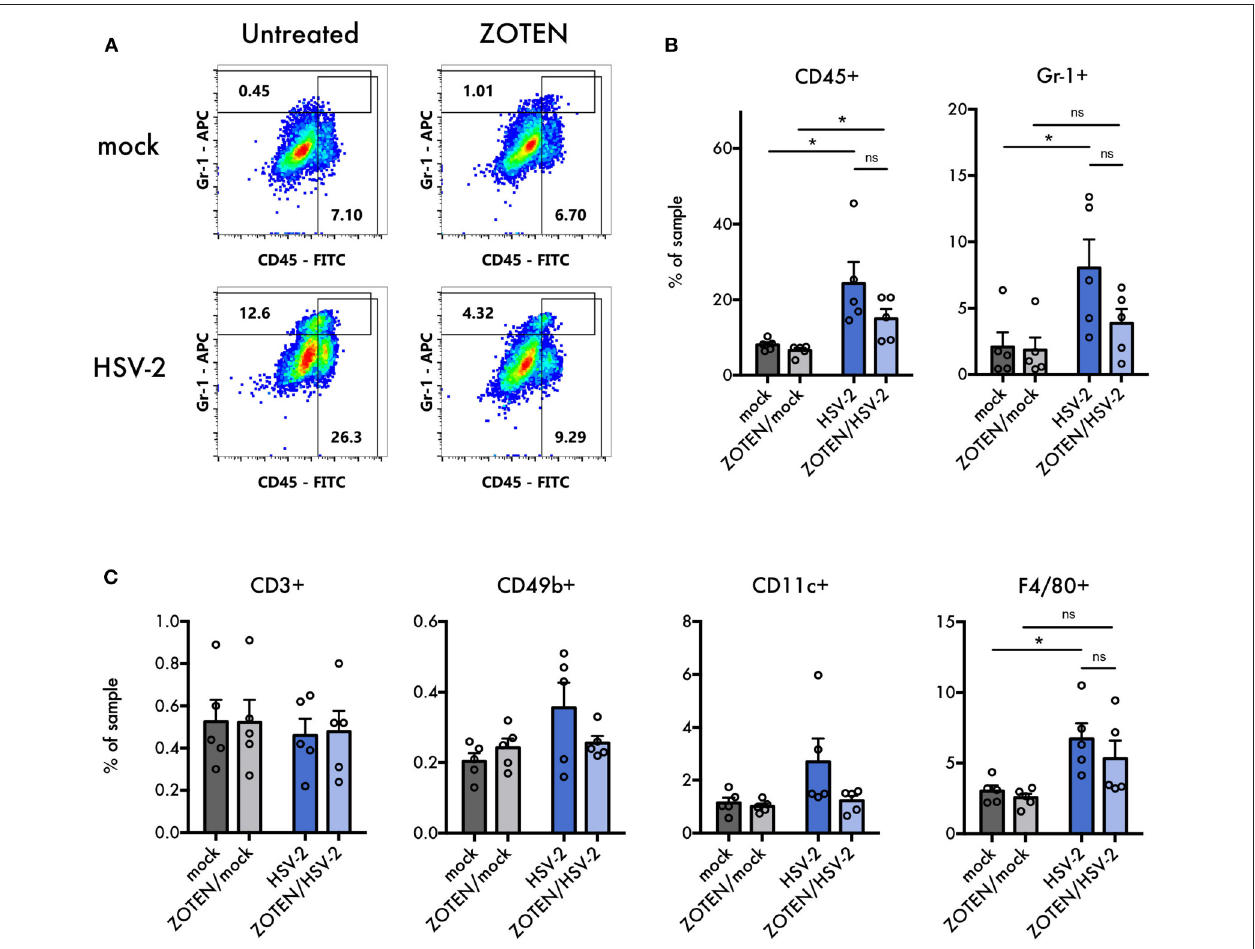
FIGURE 4 | Flow cytometry analysis of immune cell infiltration into vaginal tissues. (A) Representative flow cytometry plots of APC anti-Gr-1 vs. FITC anti-CD45. Values in gated regions indicate percentages of singlet non-debris events. (B) Quantification of flow cytometry analysis for CD45 + cells and Gr-1 + cells in vaginal tissues at 7 dpi. Error bars indicate SEM ( n = 5 per group). (C) Quantification of flow cytometry analysis for CD3 + , CD49b + , CD11c + , and F4/80 + cells in vaginal tissues at 7 dpi. Error bars indicate SEM ( n = 5 per group). Asterisks denote significant difference by two-tailed unpaired Student’s t -test, * p < 0.05, ns, or unlabeled, not